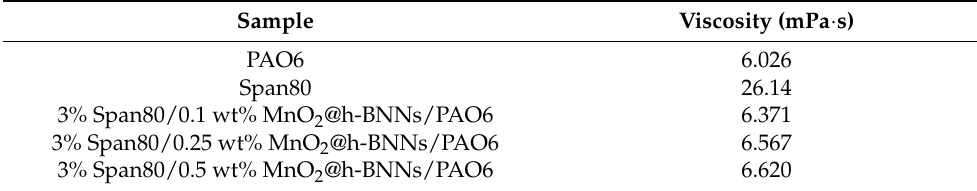
Table 2. Viscosity of oil samples at 100 °C.